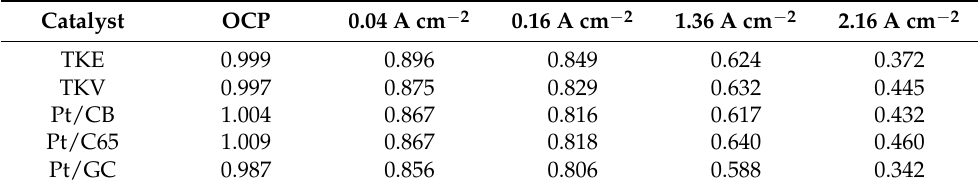
Table 4. Voltages (in V) of the MEAs at defined load